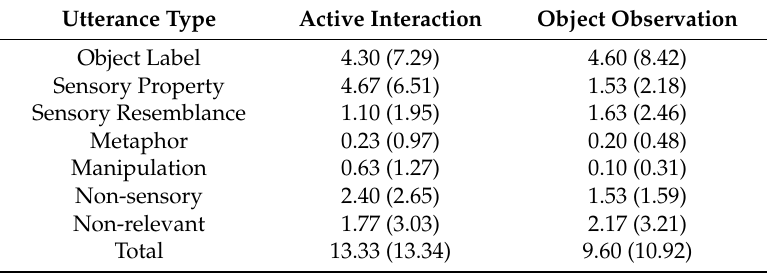
Table 4. Children’s mean numbers of utterances of each type produced during the learning phase of Experiment